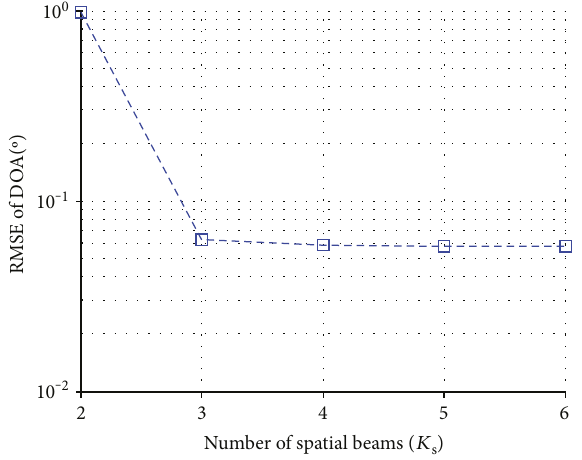
Figure 5: Parameterized DOA estimation error as a function of time-smoothing factor M .